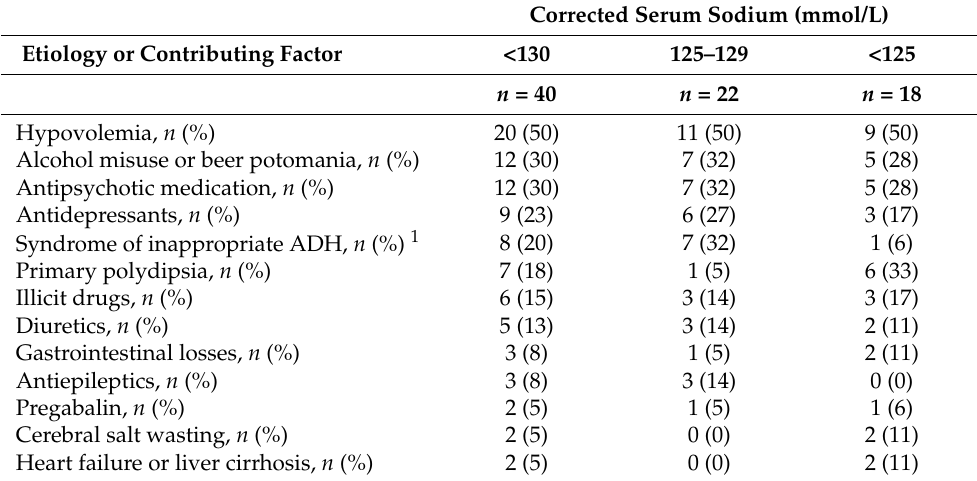
Table 3. Mechanisms of hyponatremia in order of frequency of association ( n = 40).